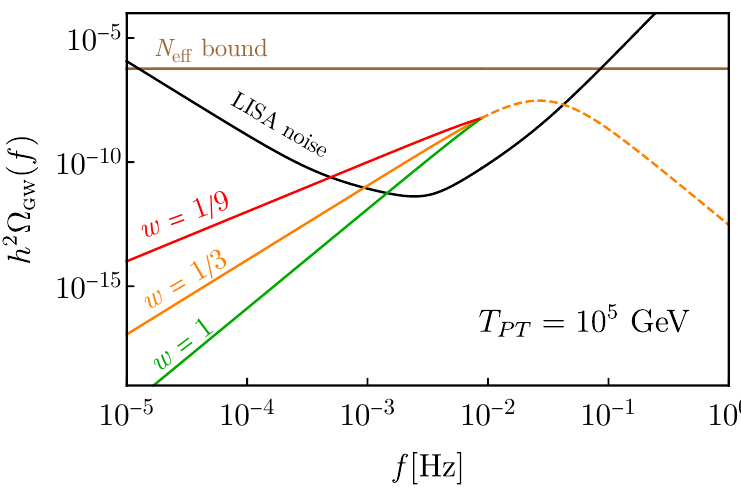
Figure 1 . A graphical representation of how the gravitational wave spectrum changes for various w ( T ) compared to the LISA sensitivity curve assuming a runtime of 10 8 s. For simplicity we are only showing how the shape changes and neglecting the rescaling of frequencies due to differing expansion histories. The dashed line indicates modes that were sub-horizon at the time the phase transition took place and their shape is unaffected by the change in expansion history. The solid lines indicate modes that were super-horizon at the time when the phase transition took place and have their shape distorted by the different expansion history.